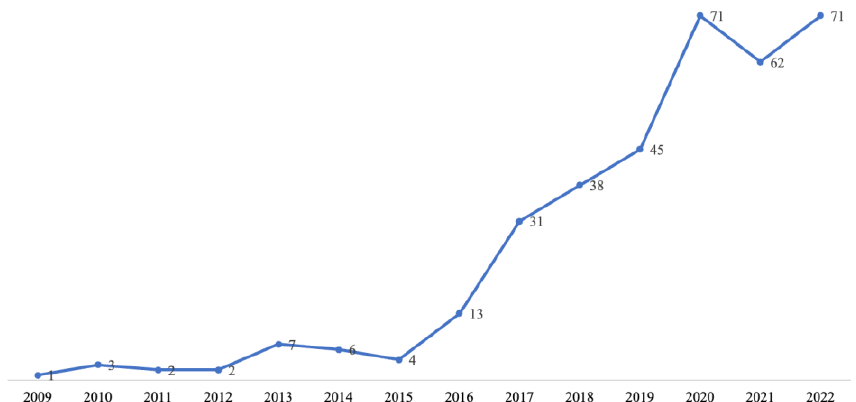
Figure 1. Dynamics of publications. Source: own elaboration.